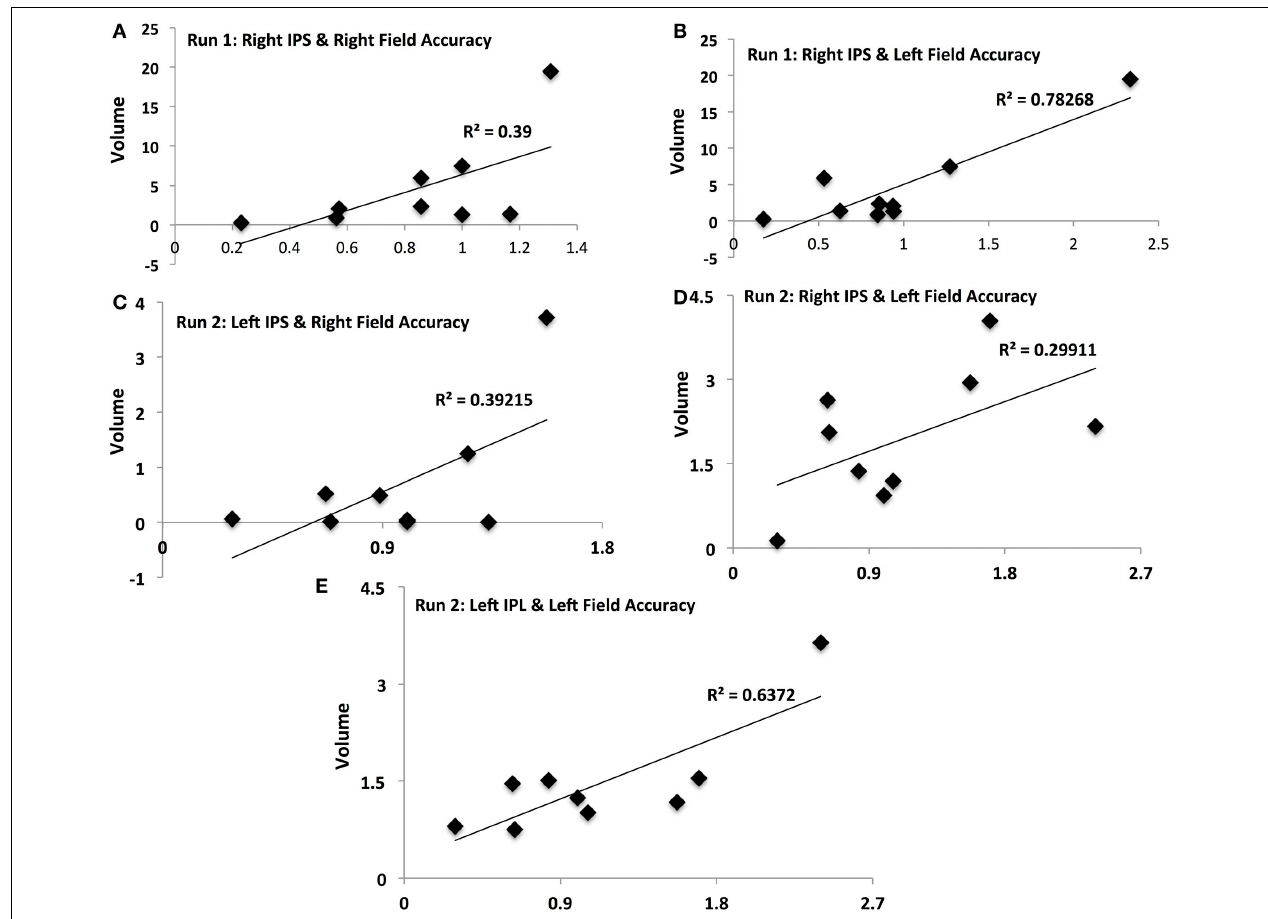
FIGURE 4 | Activation-accuracy relationships for IPS and Parietal regions. Figure shows relationship between accuracy in contralateral and ipsilateral fields in runs 1 and 2 and volumes of activation of parietal ROIs. Note that accuracy in each hemifield is represented as accuracy following rTMS normalized to that following sham. Similarly, volume of activation of an ROI or its intensity is computed as that following rTMS vs. that following